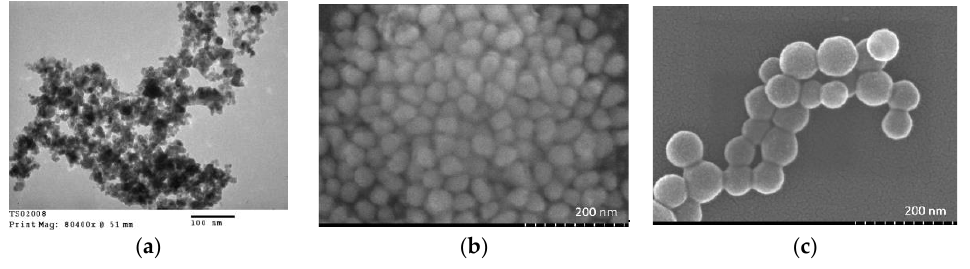
Figure 2. ( a ) TEM images of Fe 3 O 4 nanoparticles and SEM images of ( b ) FOA and ( c ) FOASET nanopar- ticles.